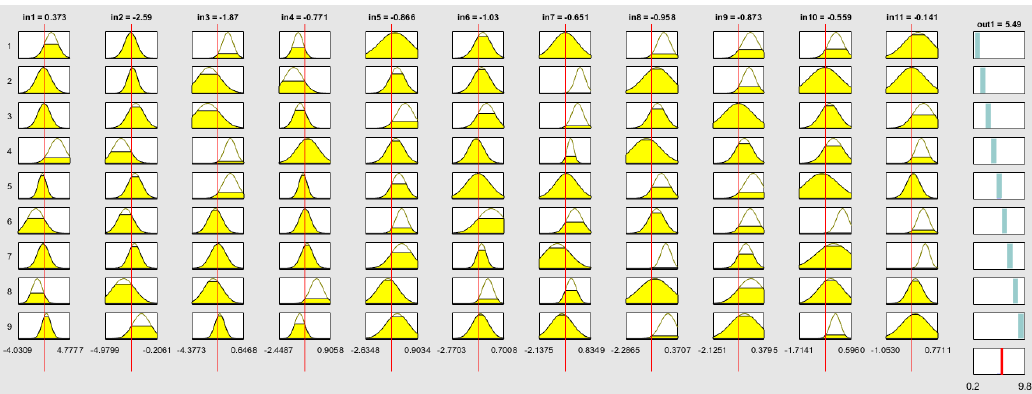
Figure 3. Rule view for feature for clean English dataset